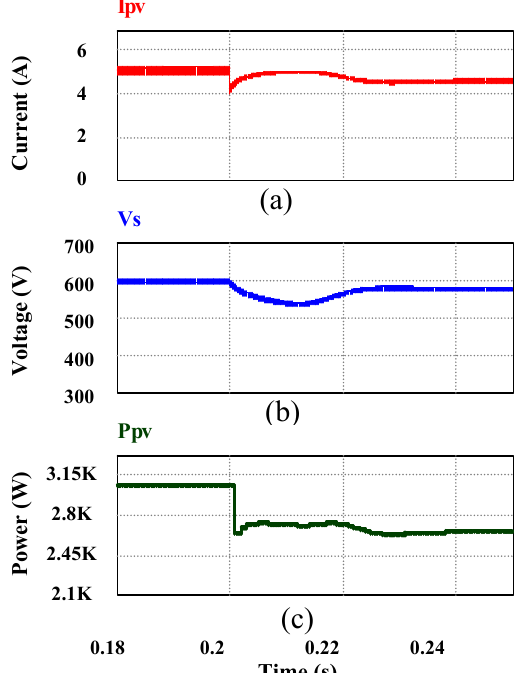
Figure 17. (From top to bottom) ( a ) Change in PV output current I pv due to the change in light intensity from 1,000 W/m 2 to 800 W/m 2 ; ( b ) corresponding change in voltage V pv because of MPPT and ( c ) power P pv